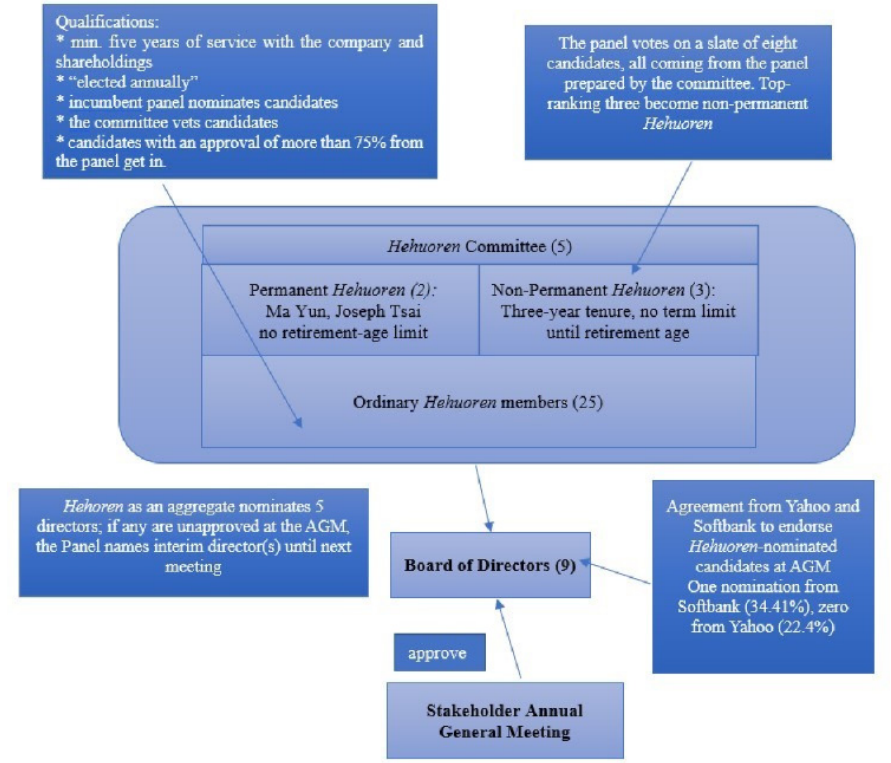
Figure 3. Power Structure of the Alibaba Hehuoren Panel in 2014. Source: Securities and Exchange Commission (2014); Hong Kong Stock Exchange (2019).